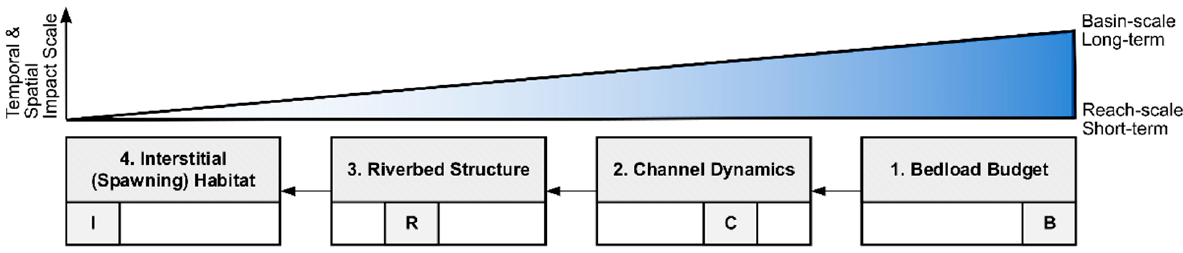
Figure 2. Principal rehabilitation and management foci of sediment augmentation measures.